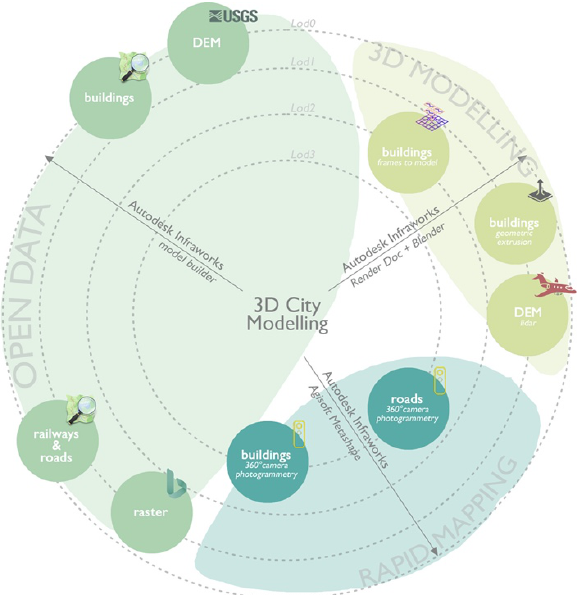
Figure 3 . B-ROAD’s 3D city modelling